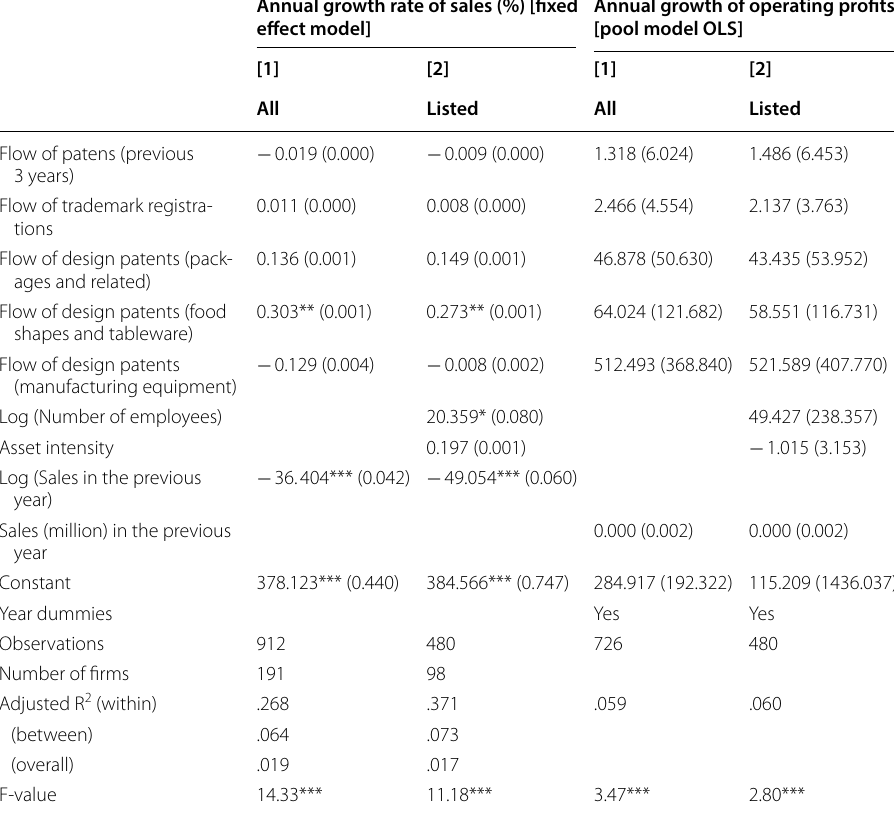
Cluster robust errors or robust errors are in parentheses *** p < 0.1%, ** p < 1%, * p < 5%,